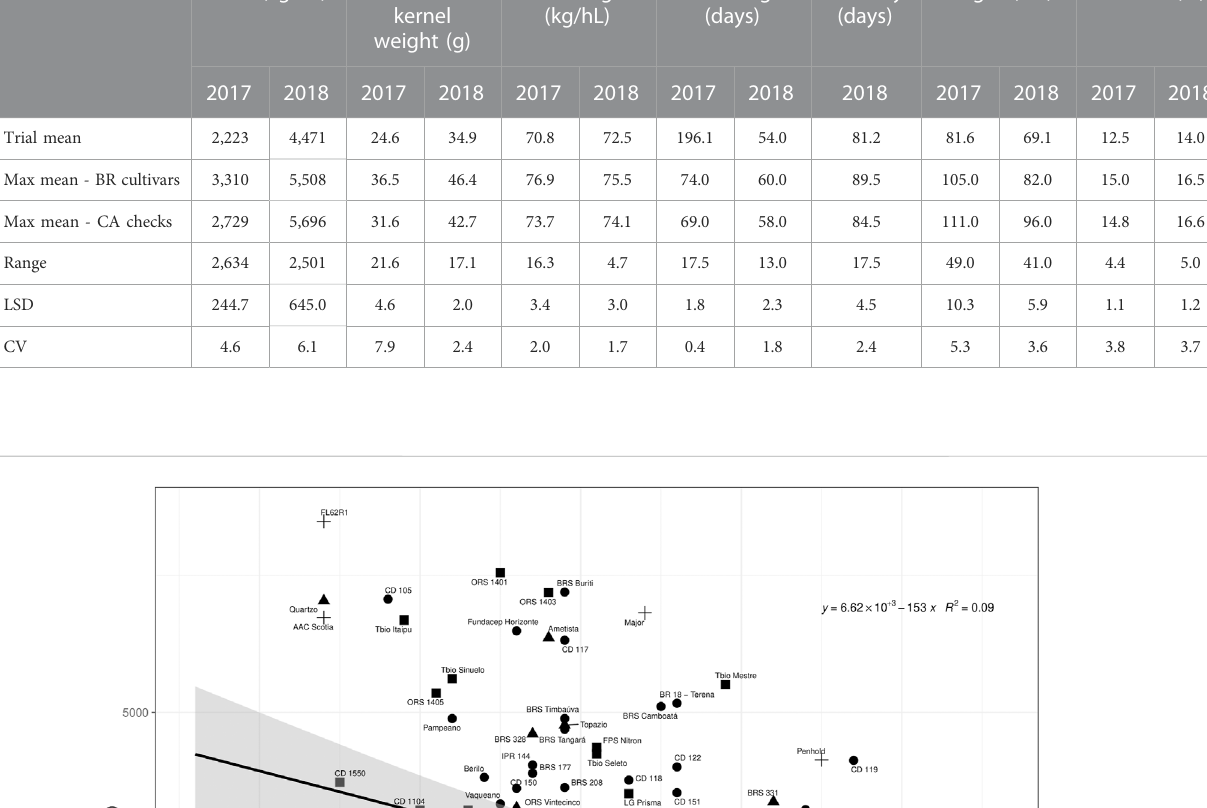
Puccinia triticina isolates, urediniospores were suspended in light mineral oil (Soltrol, Chevron Phillips Chemical Co.) and sprayed on the leaves of the spreader rows at early tillering. Subsequently, leaf rust developed on the spreader rows and urediniospores were windblown onto the test materials. Leaf rust severity (proportion